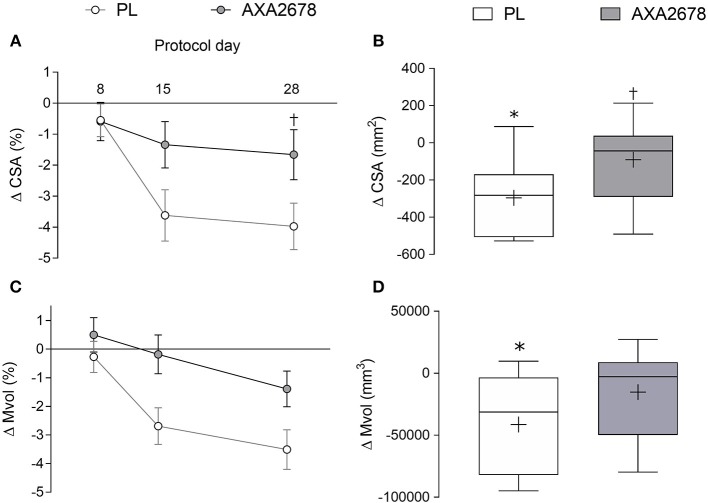
Relative and absolute changes in quadriceps muscle CSA [relative to day 1, panel (A)] and absolute changes during immobilization [day 15 min day 8, (B)]. Relative and absolute changes in quadriceps muscle volume [Mvol; relative to day 1, panel (C)] and absolute changes during immobilization [day 15 min day 8, panel (D)]. Data are presented as means ± SD (A,C). Data are presented with interquartile range (boxes) ± range (minimum and maximum), where + indicates the group mean and the median is indicated by the lines (B,D). ANOVA results panel A: time, p < 0.001; treatment, p = 0.06; time × treatment, p = 0.03. ANOVA results (C) time, p < 0.005; treatment, p = 0.03; time x treatment, p = 0.19. *Significantly different from zero (p < 0.01). †Signficantly different from PL at the same timepoint (p < 0.05).